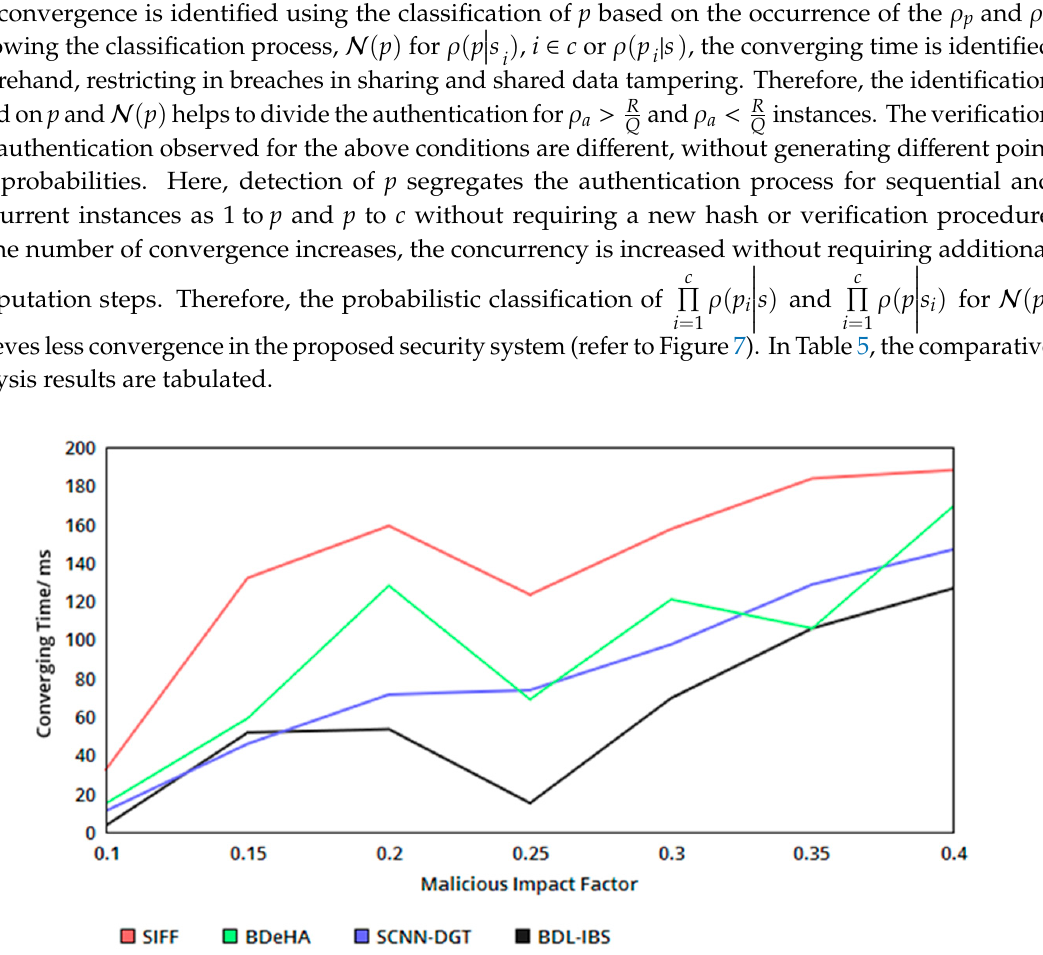
Figure 6. Avg. computation time versus malicious impact factor.